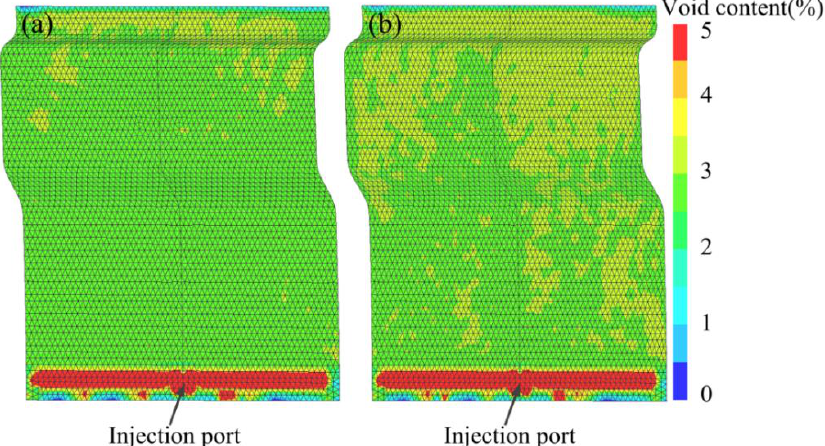
Figure 6. Typical simulation results showing void distribution and content with trials running with fiber volume fraction of ( a ) 52% and ( b ) 57%.